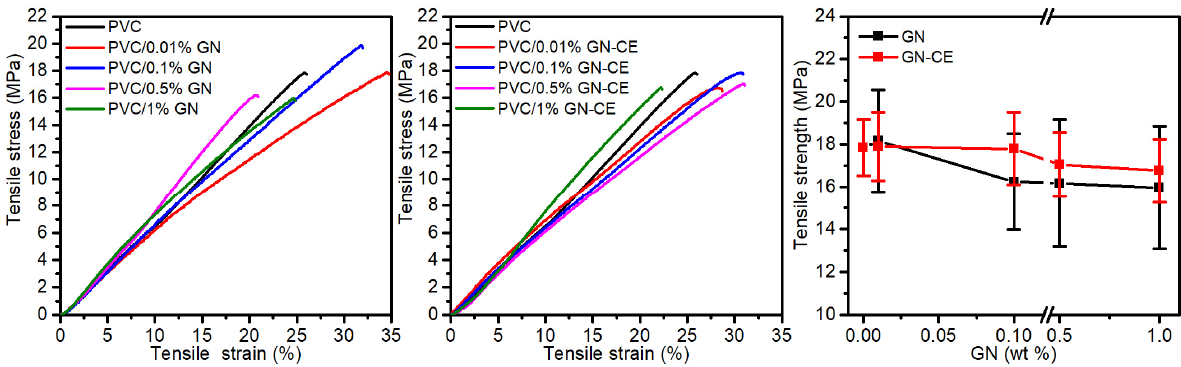
Figure 12. Mechanical properties of PVC, PVC/GN and PVC/GN-CE nanocomposites.